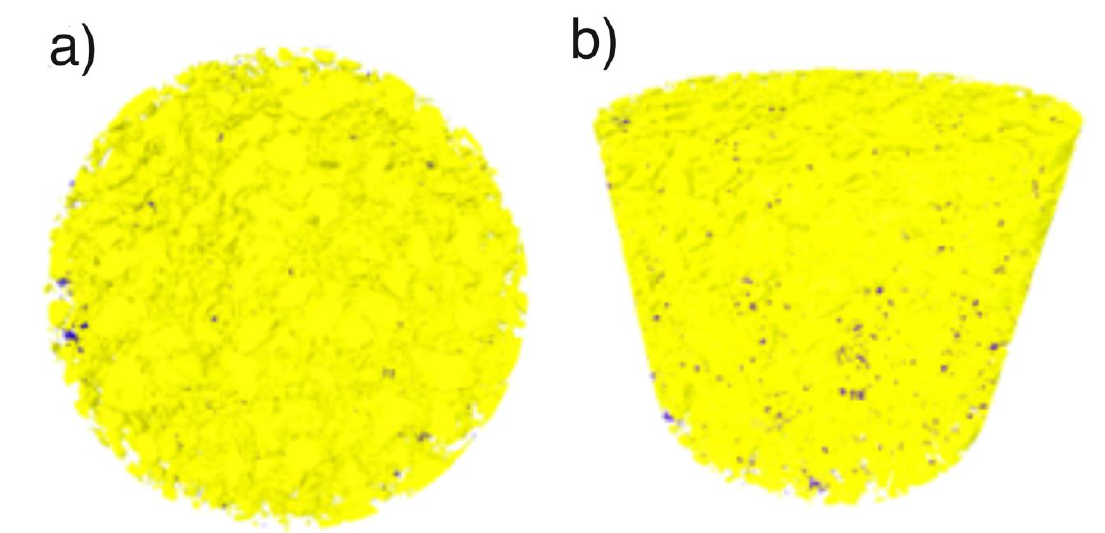
Figure 7. Three-dimensional reconstruction of HAP NPs (yellow) PLA (transparent) and pores (violet) using micro-CT, cylinder 4 mm height, 4 mm diameter: ( a ) Top view, ( b ) side view.